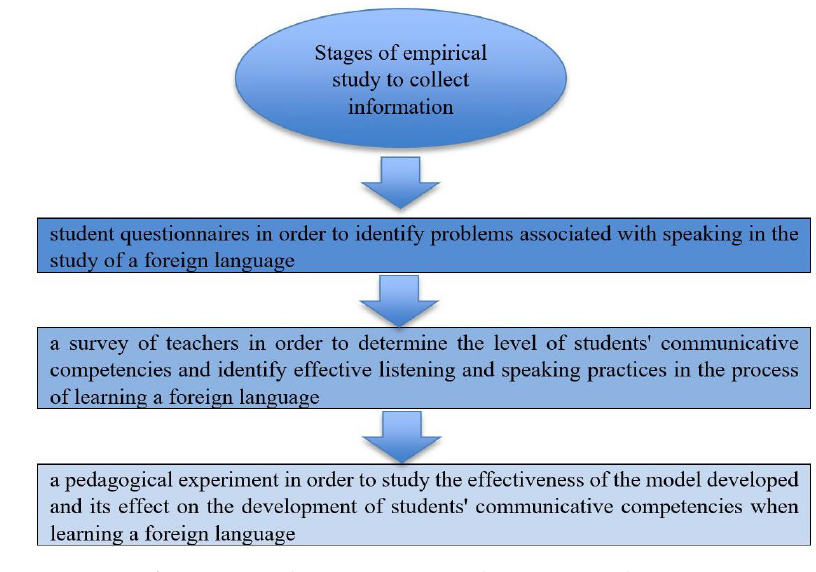
Fig. 1. Stages of the empirical study for collecting